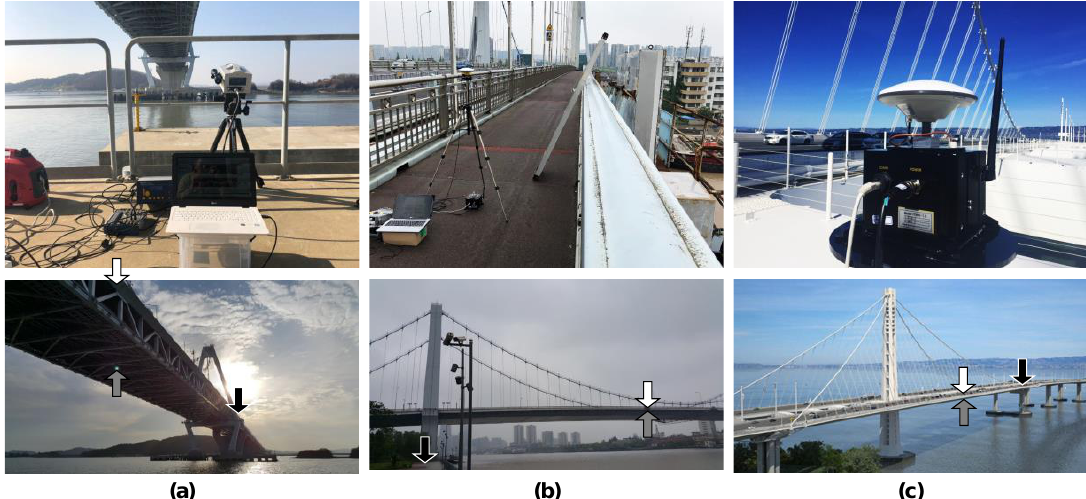
Figure 10. Field tests performed for the validation of the performance of the proposed method at ( a ) Yeongjong Grand bridge, ( b ) Qingfeng bridge, and ( c ) San Francisco–Oakland Bay bridge. The white, black, grey arrows in the bottom pictures represent the locations of sensor modules and base modules, and target points of reference measurements, respectively.